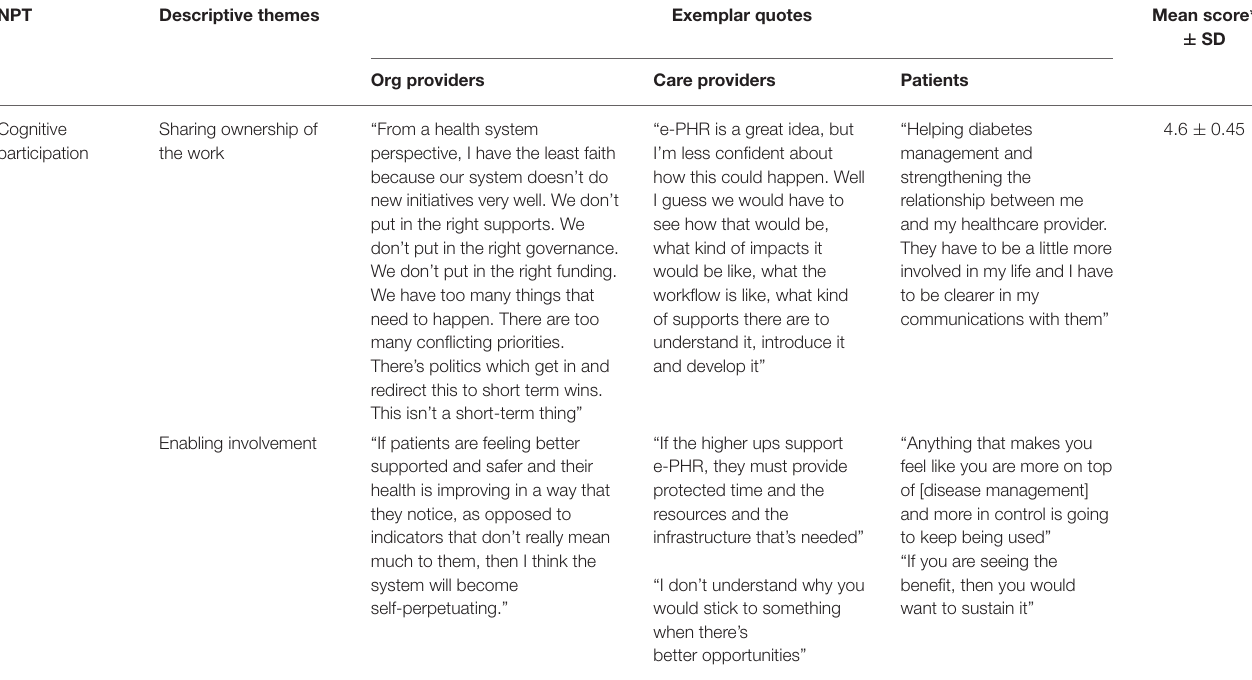
TABLE 6 | Combined qualitative and quantitative results for cognitive participation by study group.